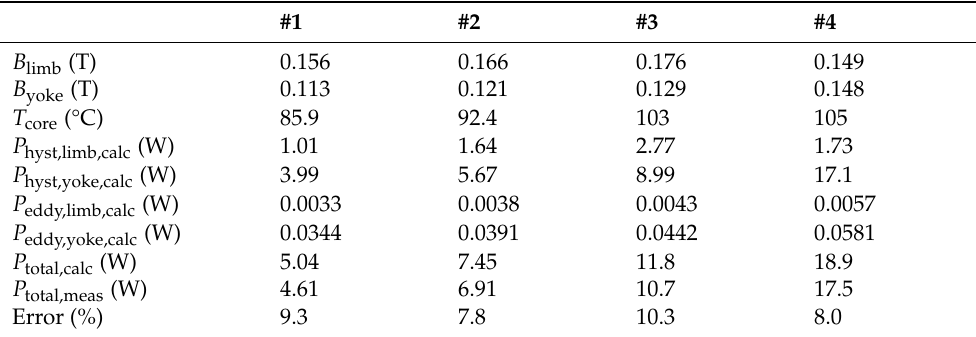
Table 5. Comparison between predicted and calorimetrically-measured core losses for the PCB- integrated